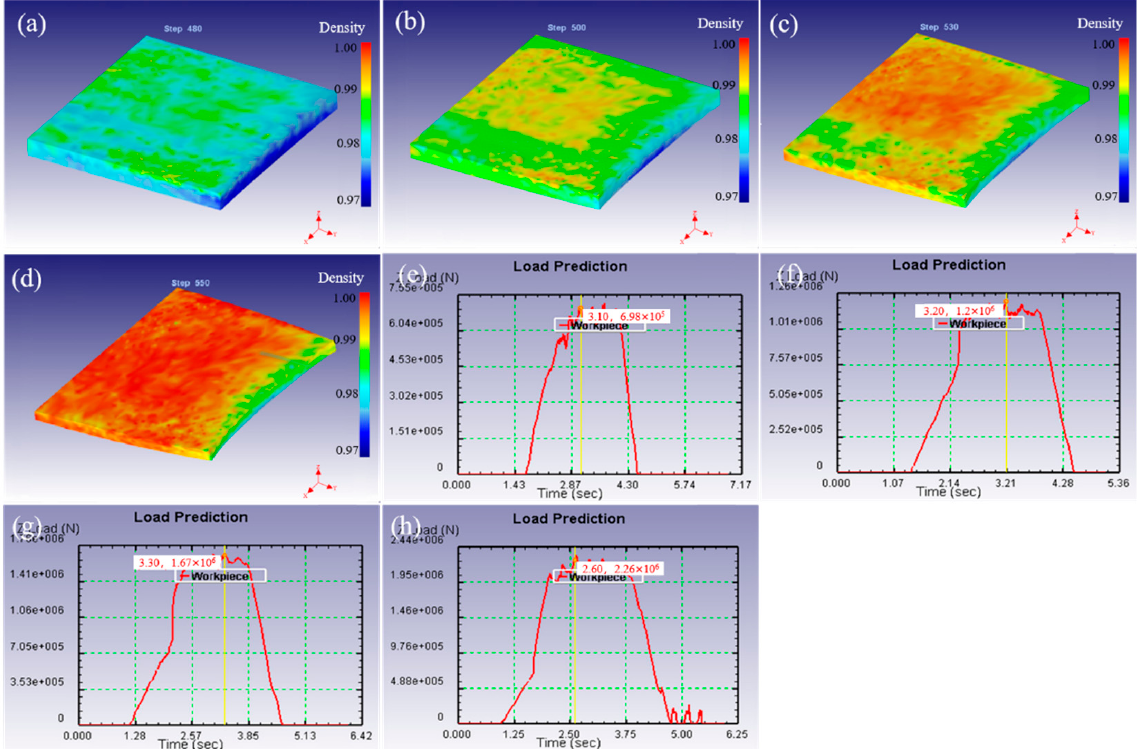
Figure 6. The distribution of density field ( a – d ), and roll force ( e – h ) by finite element simulation under different rolling reductions with 10–40%.